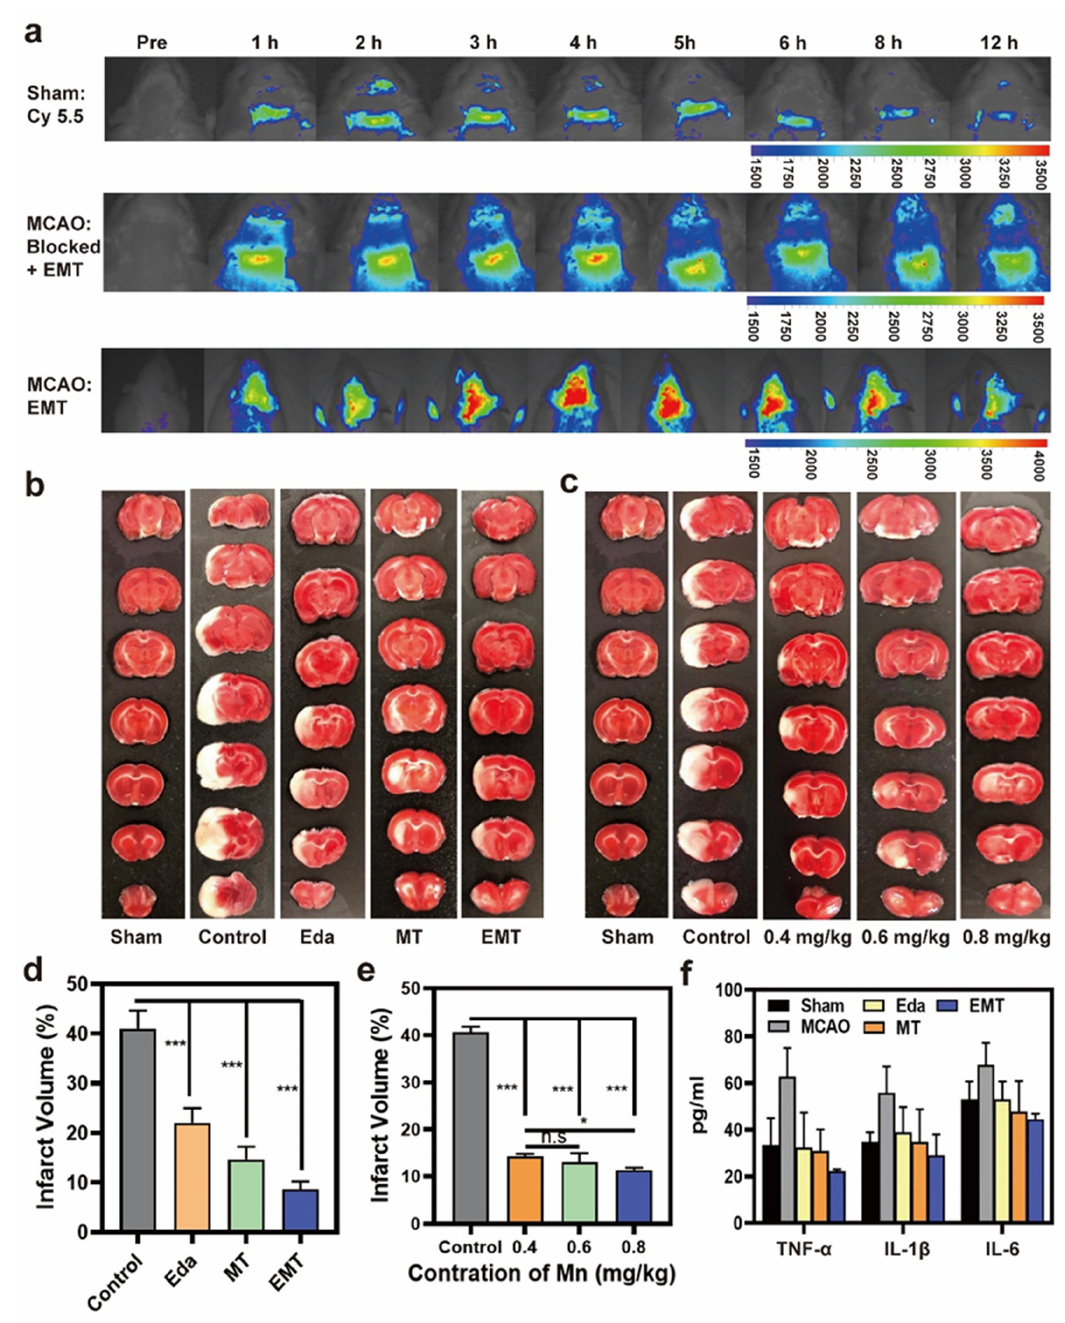
Figure 5. In vivo Cy 5.5 fluorescence imaging of EMT and TTC staining in ischemic stroke rats. ( a ). Cy 5.5 fluorescence images of different groups (Cy 5.5, Blocked + EMT, and EMT) of rats before (pre) and after injection with Cy 5.5-labeled EMT over time (1, 2, 3, 4, 5, 6, 8, and 12 h). ( b ). Representative photograph of TTC staining of coronal brain sections in every set within 24 h of stroke in Eda, MT, and EMT groups. ( c ) Its percentage of relative infarct area. ( c ). Representative photograph of TTC staining with different concentrations of Mn (sham, control, 0.4 mg/kg, 0.6 mg/g, and 0.8 mg/kg). ( d ). The volume ratio of whole brain analyzed by Image Pro Plus software from TTC staining of different groups (control, Eda, MT, and EMT), *** p < 0.001. ( e ) The volume ratio of whole brain analyzed by Image Pro Plus software in different concentrations of Mn, * p < 0.05. *** p < 0.001. ( f ). ELISA assay to test the levels of TNF- α , IL-1 β , and IL-6 in MCAO rats after treating them with Eda, MT, and EMT.